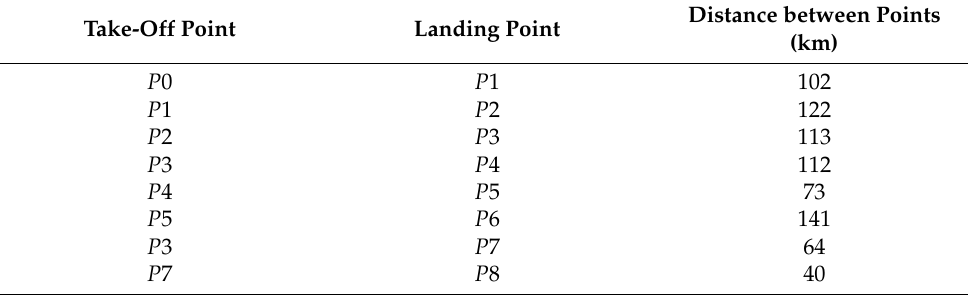
Figure 5. ( a ) The monitoring object—an oil pipeline with 9 checkpoints. ( b ) An example of the UAV of convertible type. Table 3. The distance between